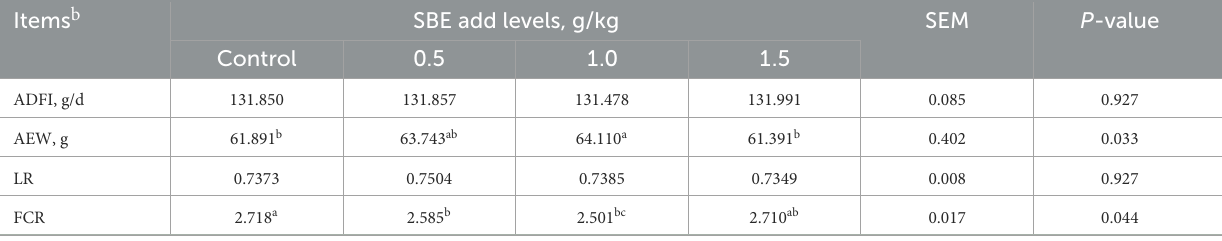
TABLE 2 Effect of dietary SBE on production performance of laying ducks a